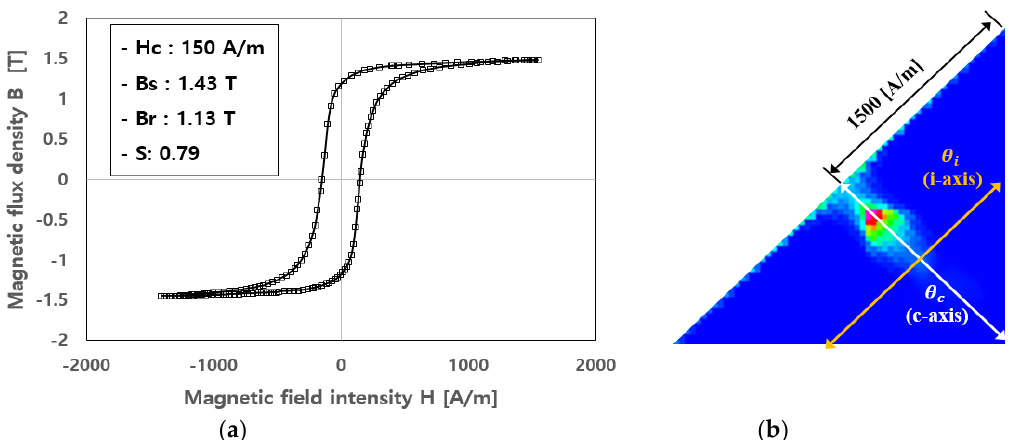
Figure 9. Magnetic properties of the SPCC: ( a ) B − H curve; ( b ) Preisach density distribution on the Preisach plane.